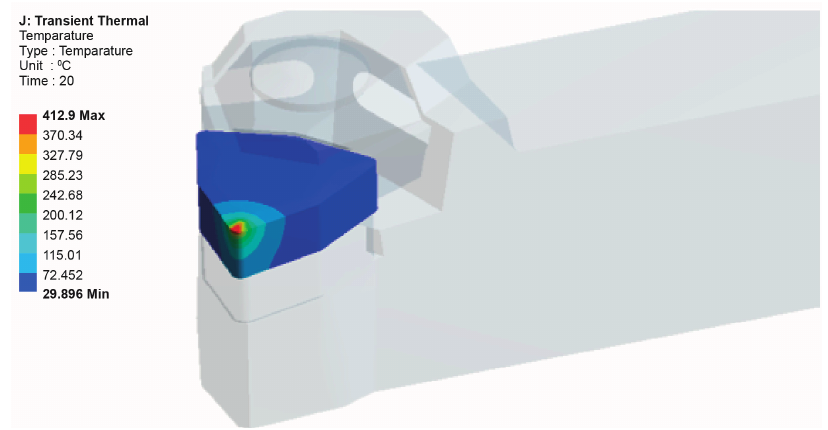
Figure 15. Temperature distribution on the cutting insert.